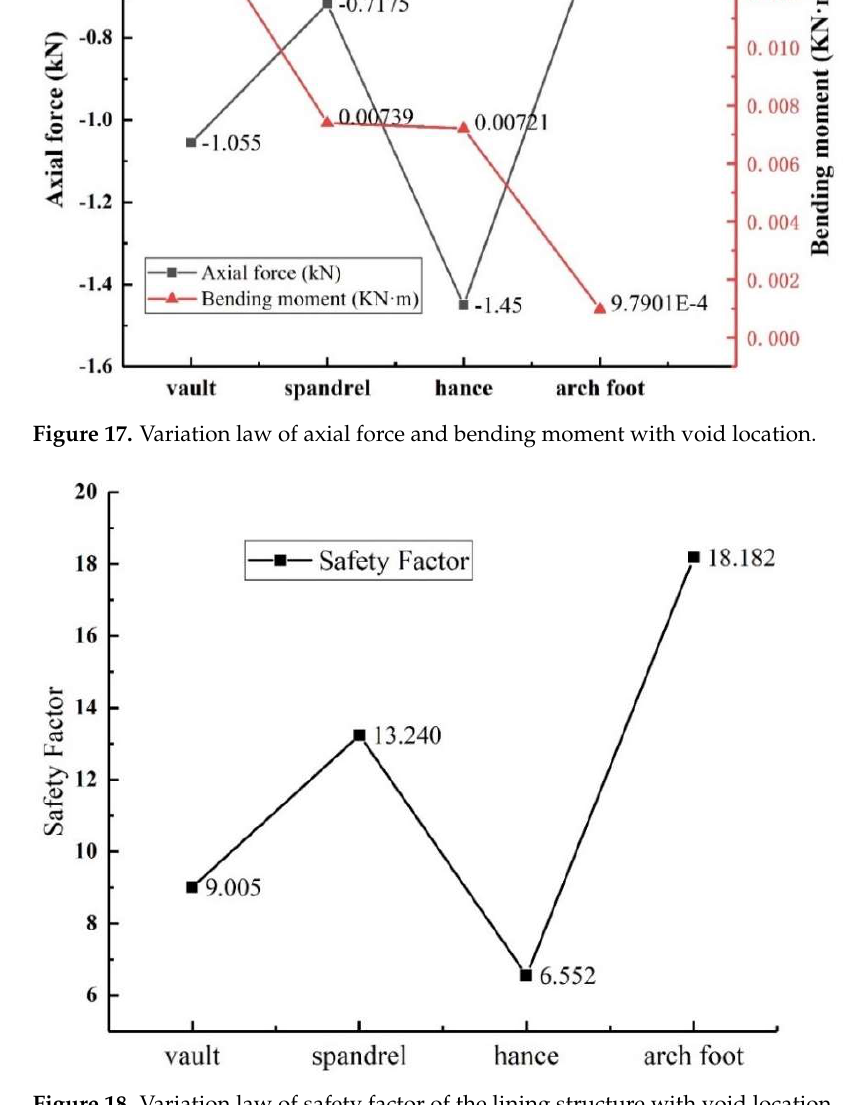
Figure 18. Variation law of safety factor of the lining structure with void location.